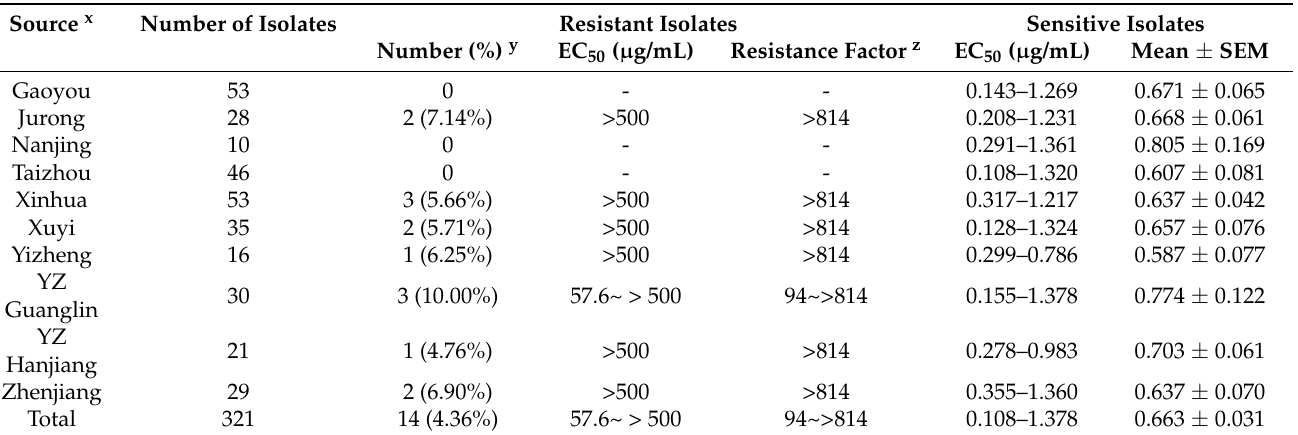
Table 1. Carbendazim resistance in field isolates of Ustilaginoidea virens from different regions of Jiangsu Province.